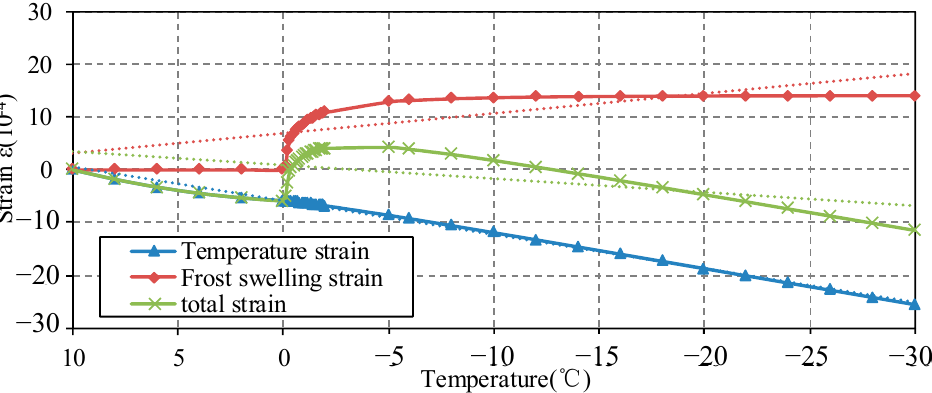
Figure 7. The low-temperature strain process of mortar specimen.